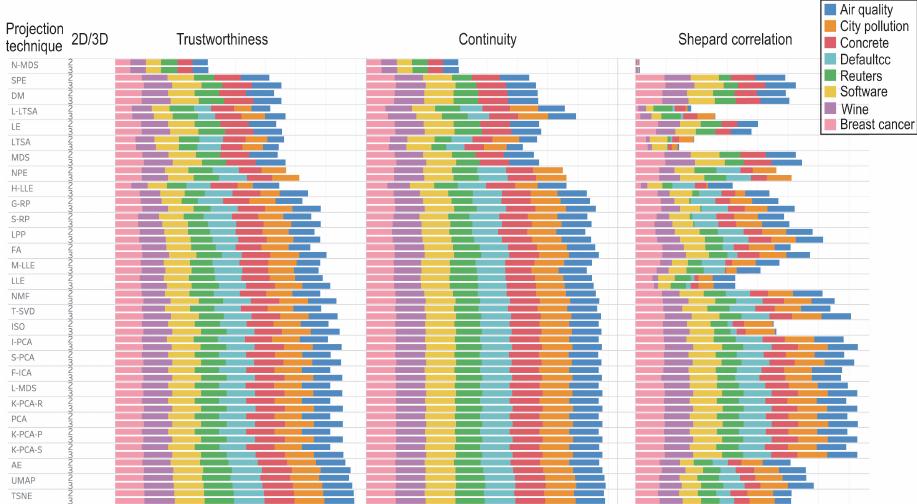
Figure 1. Quality metrics per projection technique (rows), dataset (colors), and projection dimension (2D vs. 3D, second column), sorted ascendingly on technique trustworthiness.